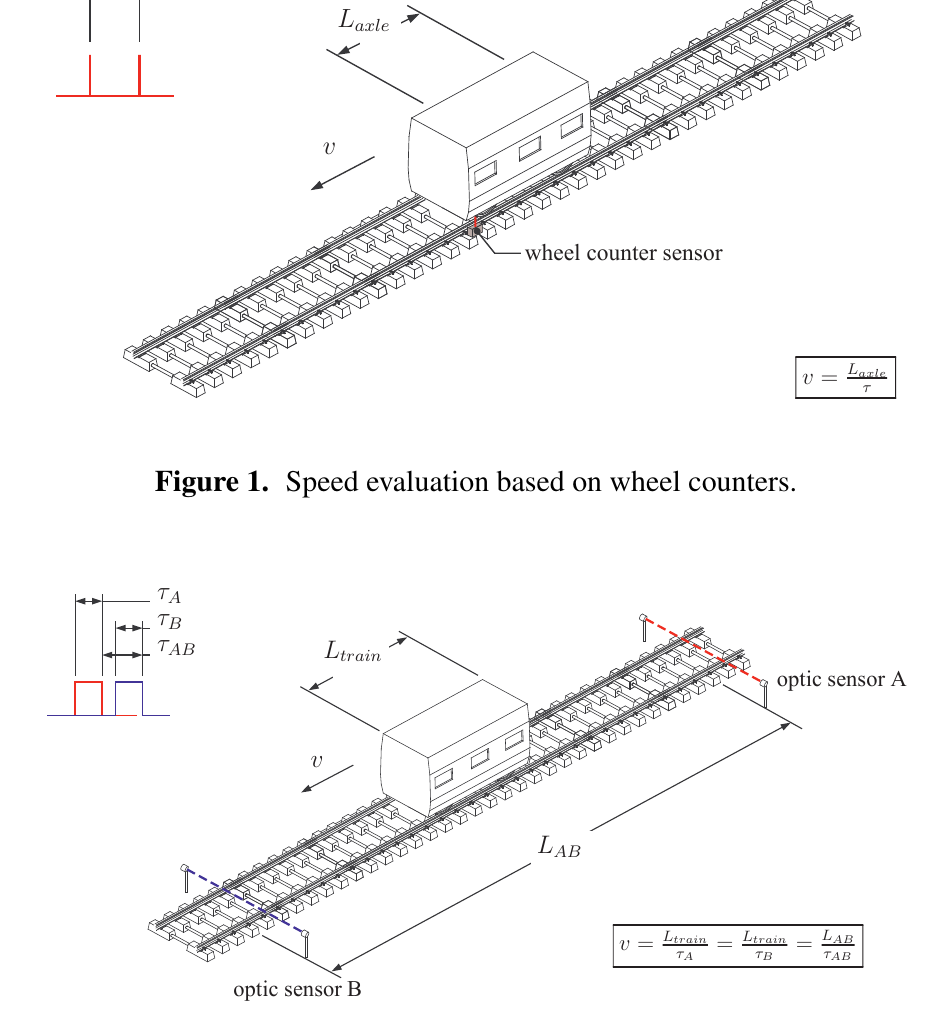
Figure 2. Speed evaluation based on two optic sensors placed along the